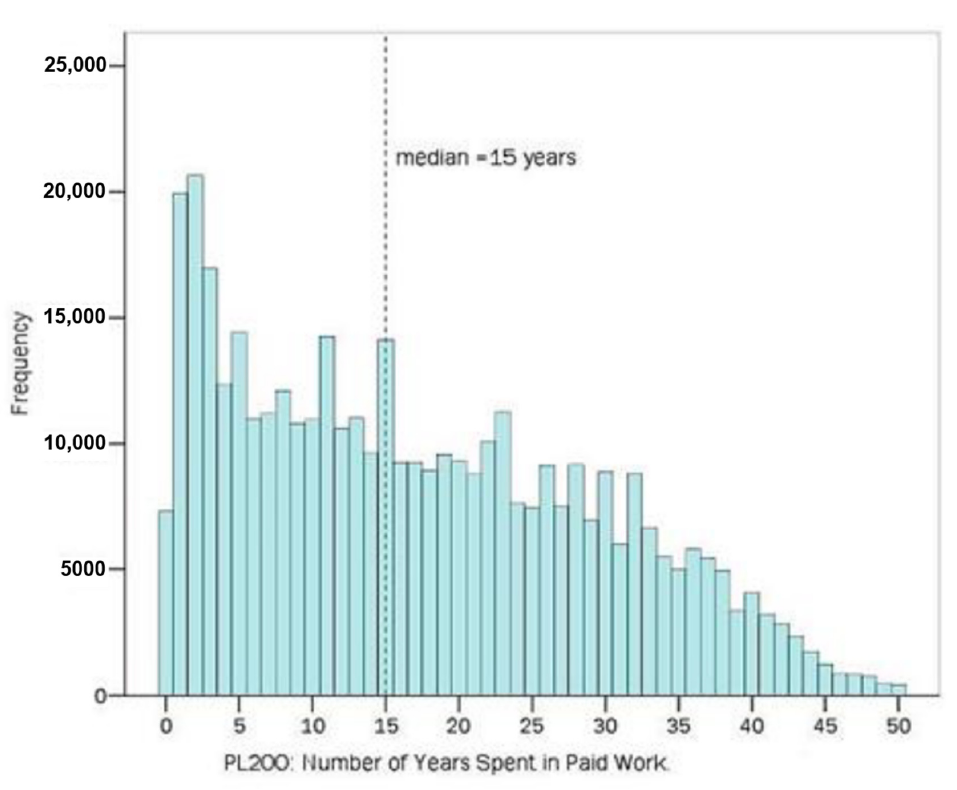
Figure 6. Distribution of all employees by duration of professional experience (2019). Data source: EU-SILC (2020). Eurostat (2020).